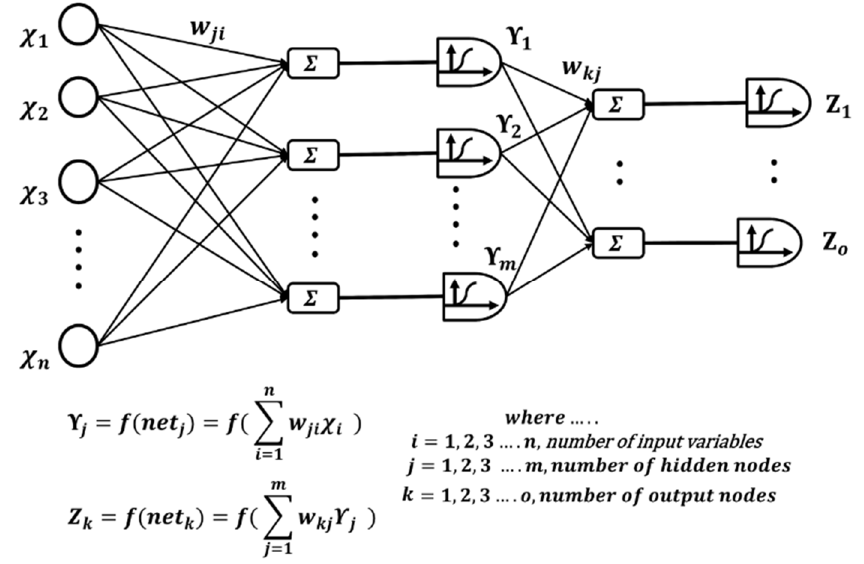
Figure 2. The architecture of an artificial neural network.